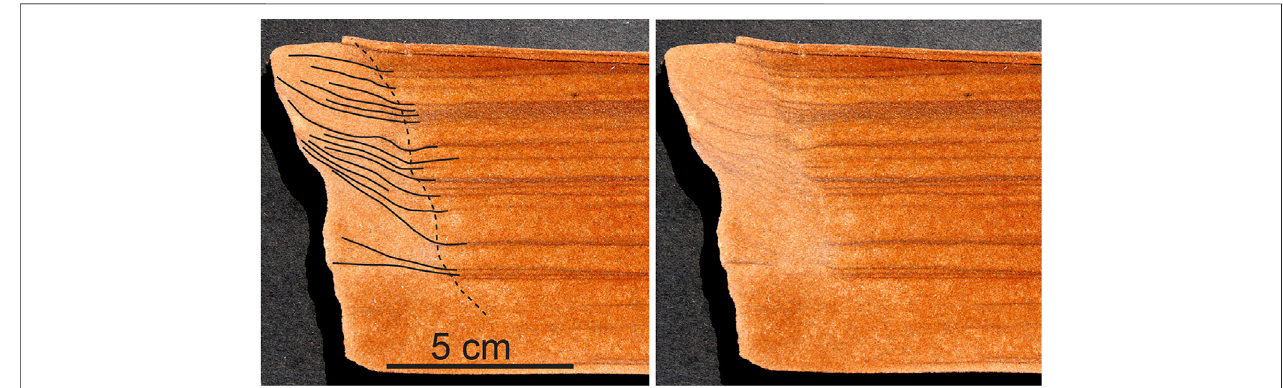
FIGURE13| DeformedlaminaeontheleftedgeofaCoconinoSandstone fl oatsample,withlowerporosityinthedeformedarea.Deformedlaminaearehighlighted in left photo.